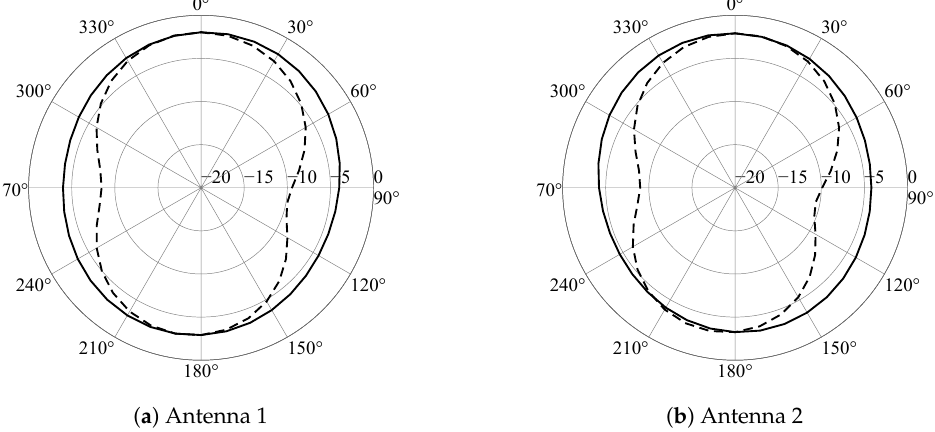
Figure 11. Realized gain of the antennas with φ = 0 ◦ (solid line) and φ = 90 ◦ (dashed line) for Configuration